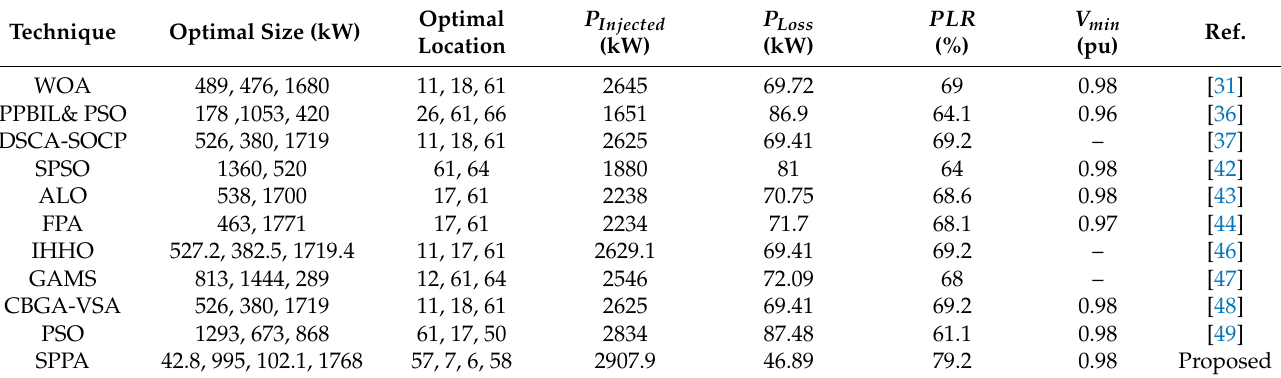
Table 2. Comparison and performance analysis of